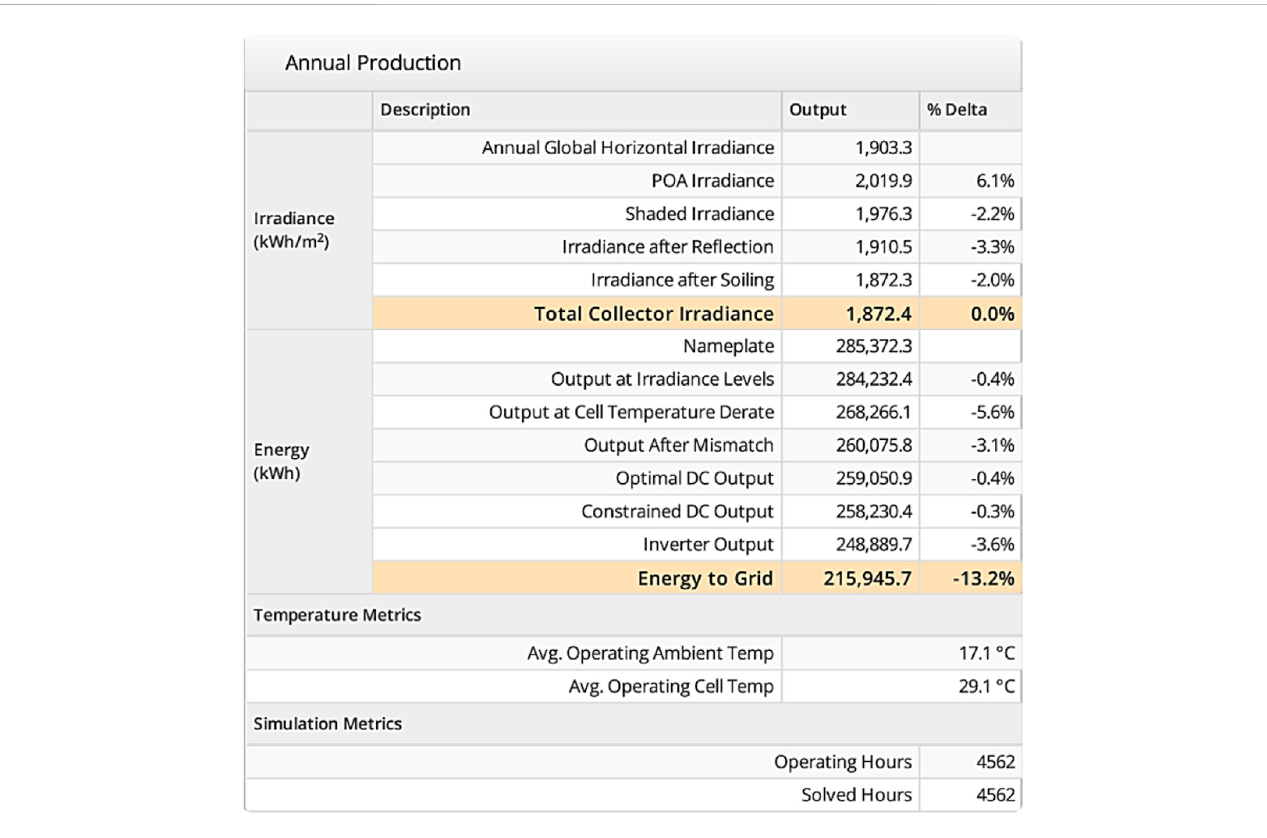
FIGURE 11 Estimated annualized power generation by PV system.